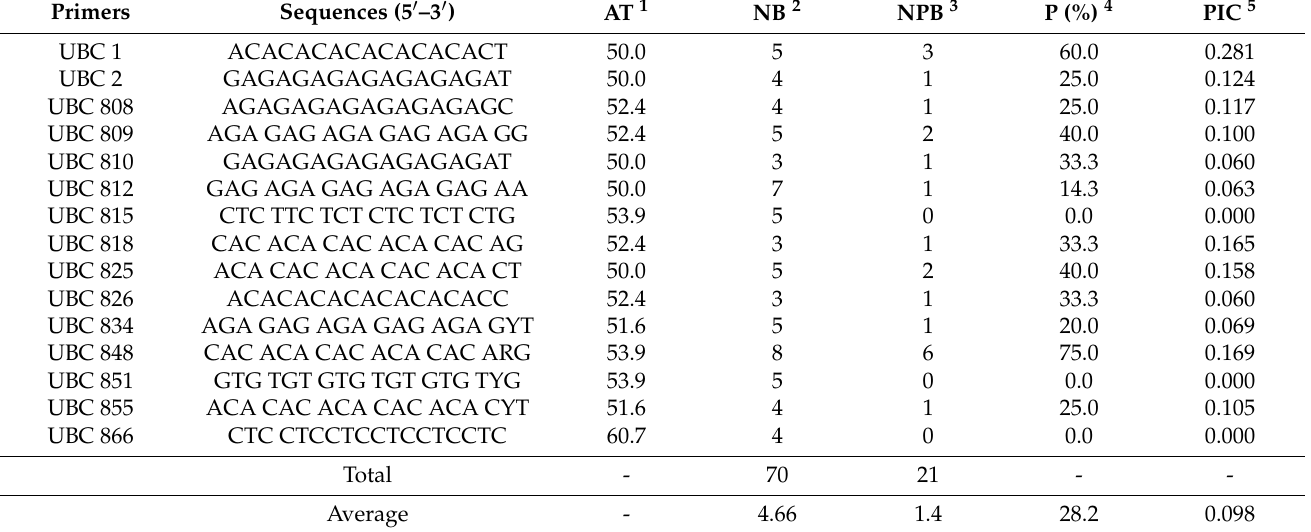
Table 1. General characteristics of ISSR and SSR primers selected for evaluation of somaclonal variation and genetic diversity in Hancornia speciosa